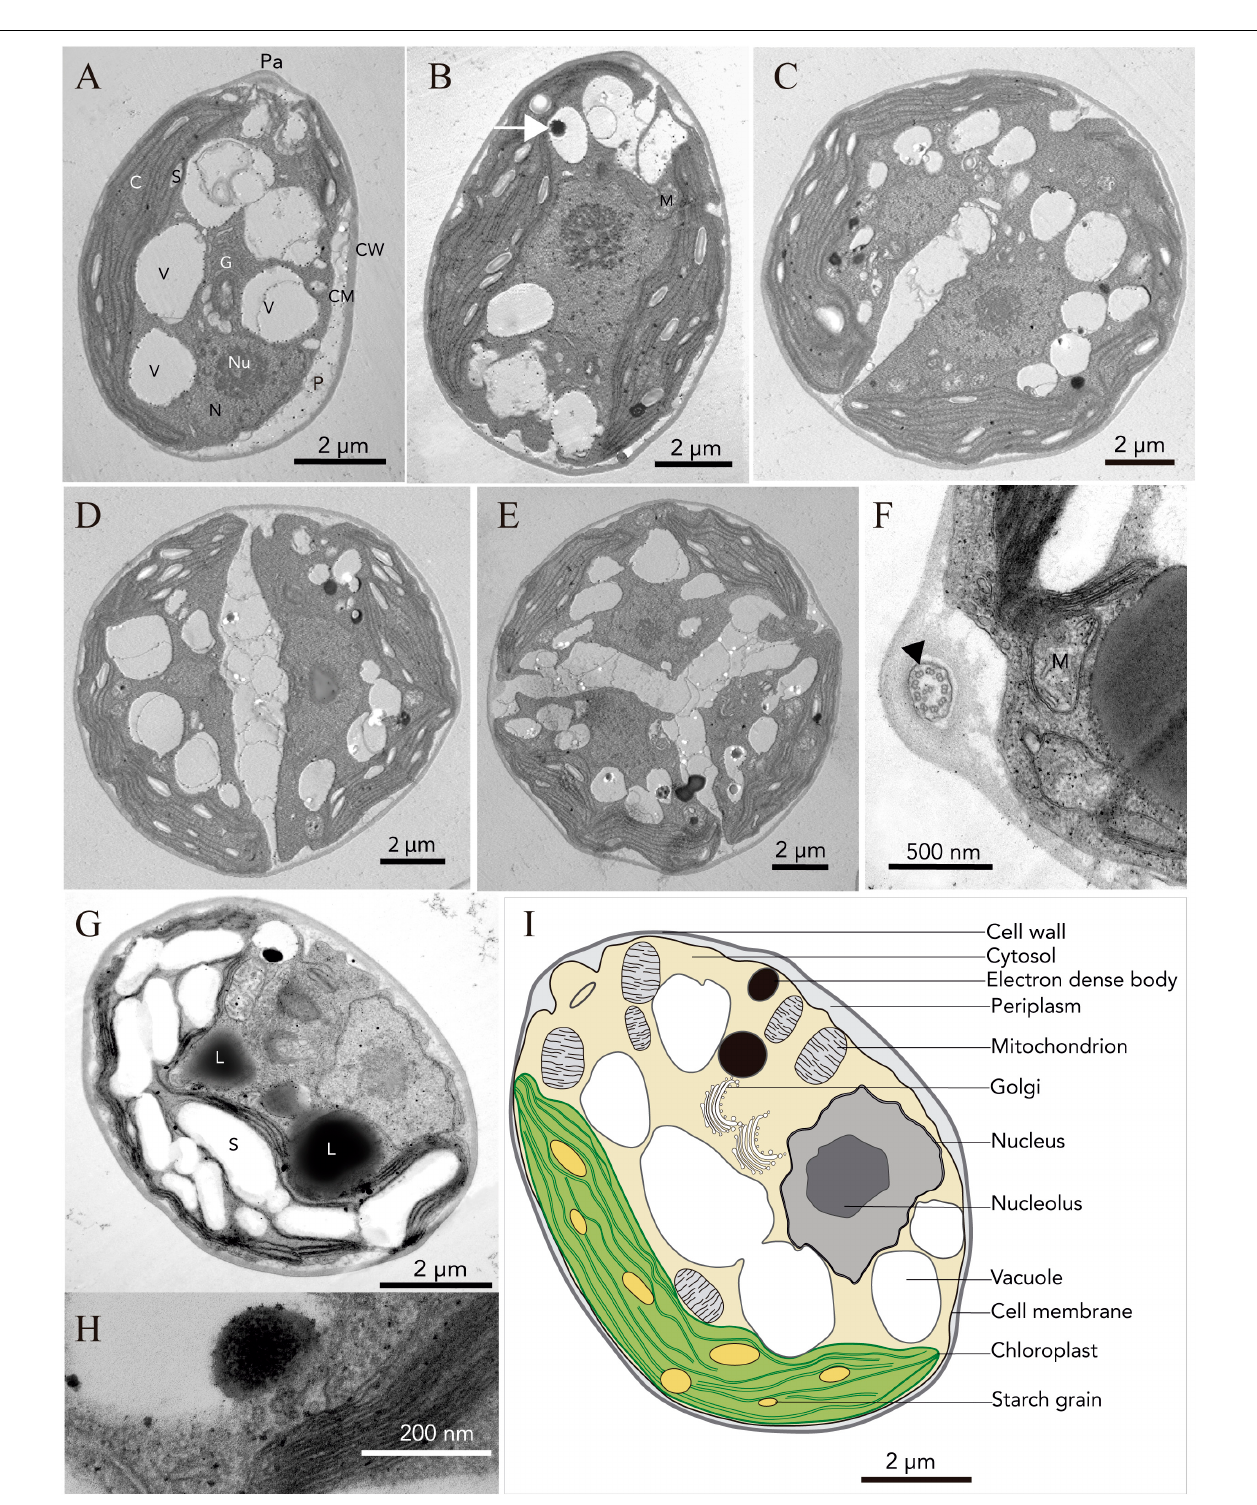
FIGURE 3 | Ultrastructure (TEM) of Chlorominima collina CCAP 6/1 (A) Longitudinal section of a zoospore. (B) Mature vegetative cell (white arrow: electron dense body). (C–E) Zoospores in the process of cell division, where the protoplast is divided transversely. (F) Cross section of the flagellum showing the 9 + 2 axonema structure (black arrow). (G) Old culture cell. Pa, papilla; C, chloroplast; S, starch grains; V, vacuole; N, nucleus; Nu, nucleolus; G, Golgi apparatus; P, periplasm; CM, cell membrane; CW, cell wall; M, mitochondria; L, lipid droplet. (H) Plastoglobule in the chloroplast. (I) Consensus schematic drawing of a vegetative cell of Cm. collina